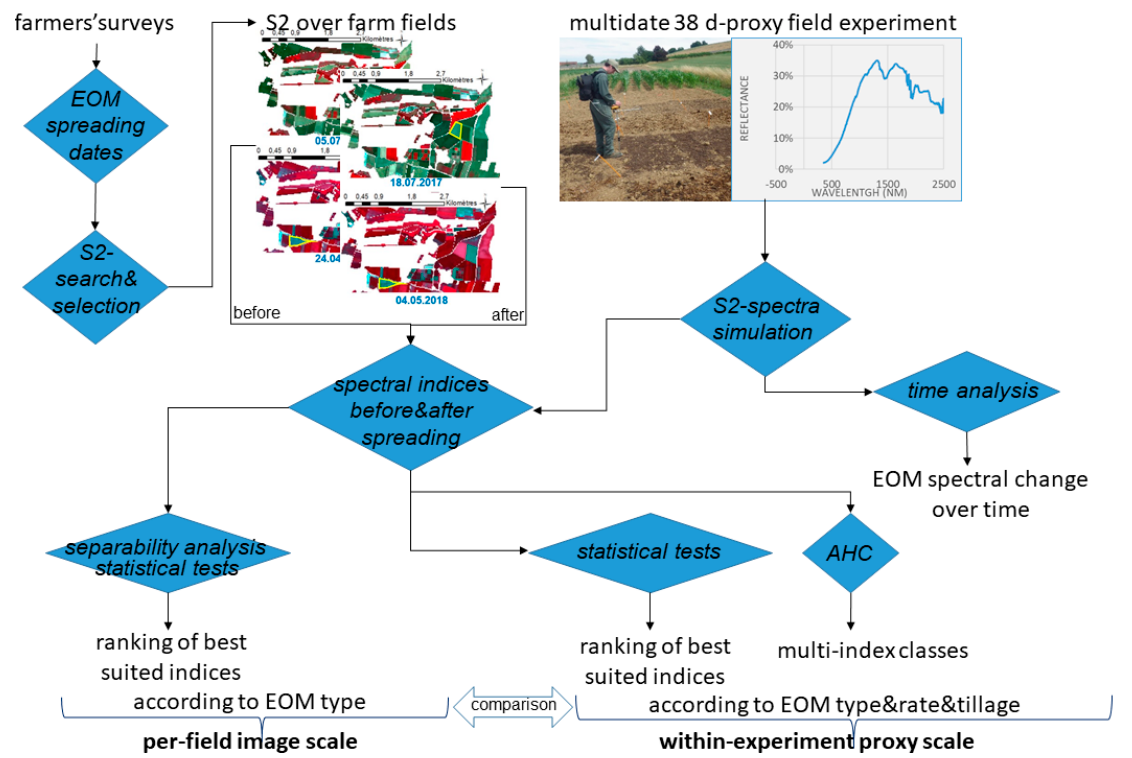
Figure 1. Flowchart of the overall approach.